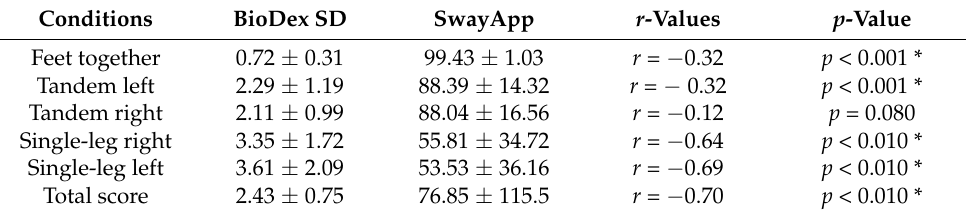
Table 1. BESS (Balance Error Scoring System) Scores for each device.